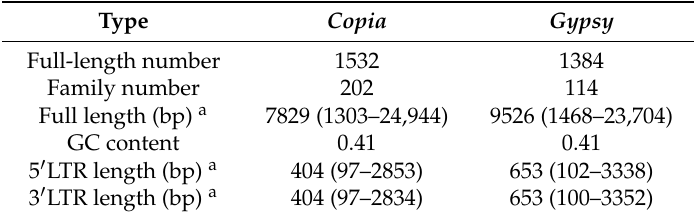
Table 1. Summary of the Copia and Gypsy long terminal repeat (LTR) families.